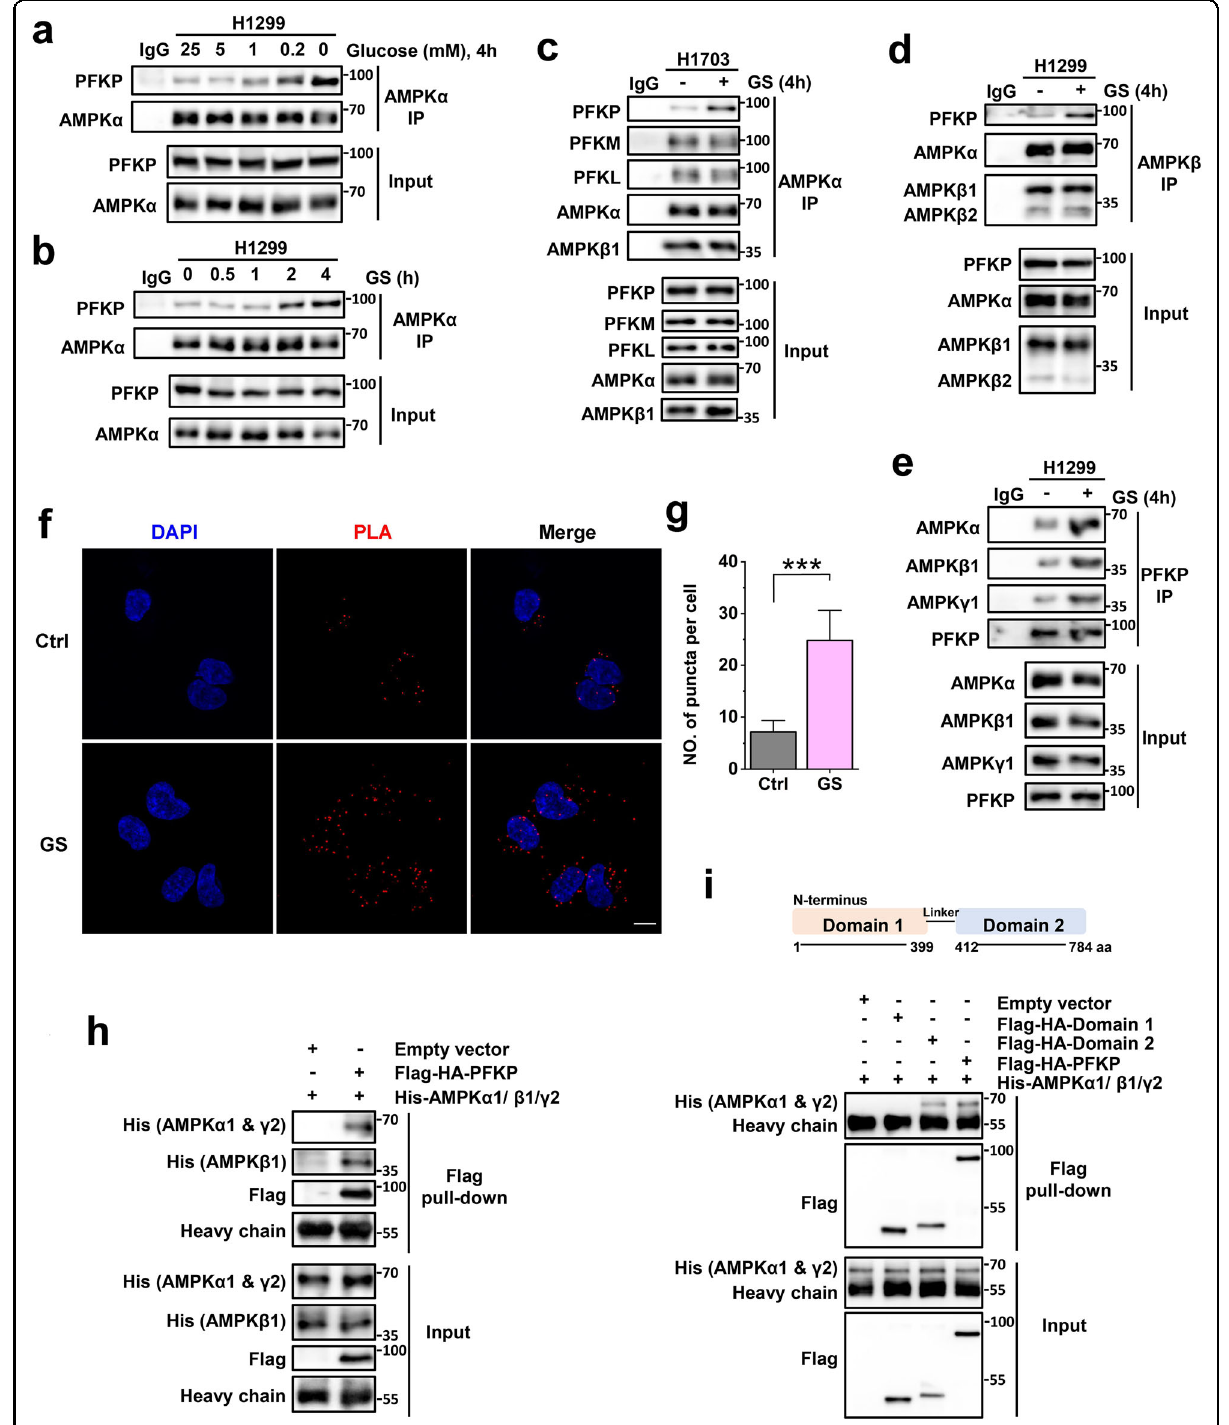
Fig. 2 GS enhances the interaction between PFKP and AMPK. a Immunoprecipitation (IP) of AMPK α in H1299 cells treated with different levels of glucose. b AMPK α IP in H1299 cells treated with GS for different time points. c – e IP of AMPK α in H1703 ( c ), AMPK β in H1299 ( d ), and PFKP in H1299 ( e ) cells under control (Ctrl) or GS. f Proximity ligation assay (PLA) of PFKP and AMPK β 1/2 in H1299 cells under control (Ctrl) or GS for 4 h. Scale bar, 10 μ m. g Counts of PLA puncta in H1299 cells under control ( n = 38) or GS ( n = 44). Data are shown as means ± SD with n indicating the number of biological replicates. * P < 0.05, ** P < 0.01, *** P < 0.001 by two-tailed Student ’ s t -test. h , i In vitro protein – protein interaction assay of puri fi ed PFKP ( h ) or PFKP domains ( i ) with AMPK. Flag-HA tagged PFKP and PFKP domains were puri fi ed by Flag IP and then incubated with His-tagged AMPK α 1/ β 1/ γ 2 for 1 h at room